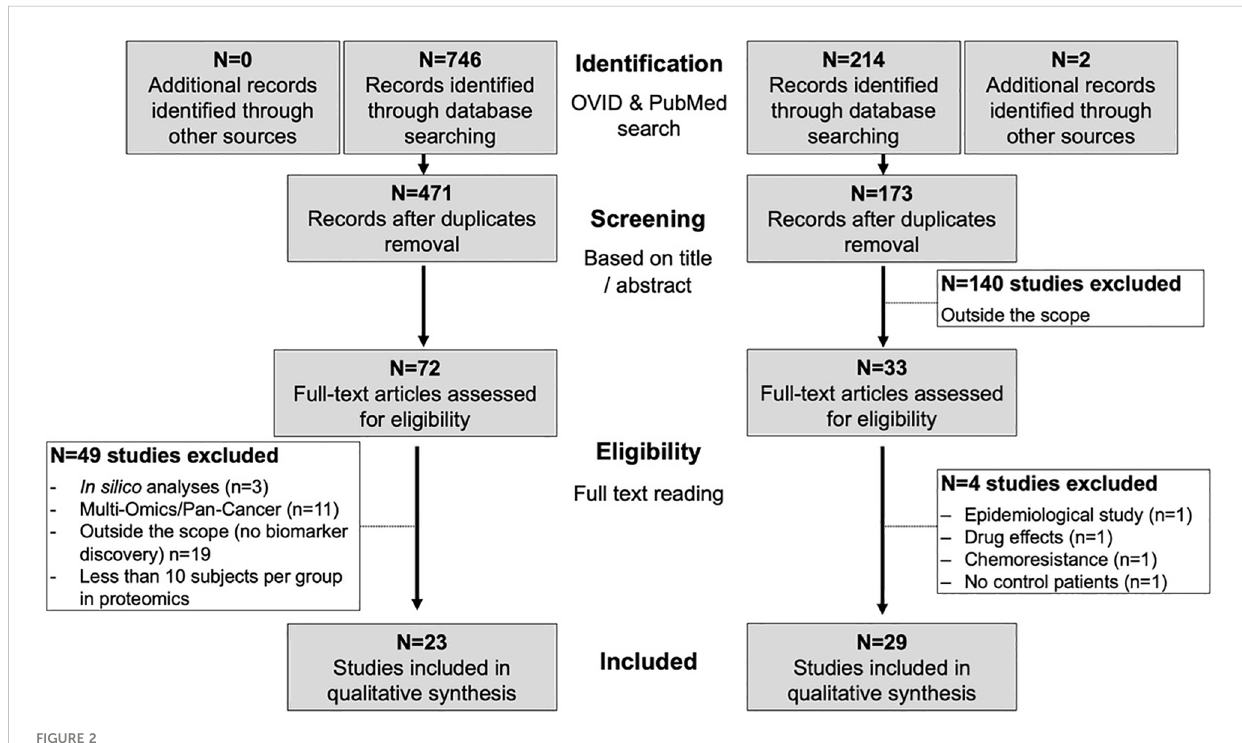
FIGURE 2 Work fl ow of the systematic search and paper